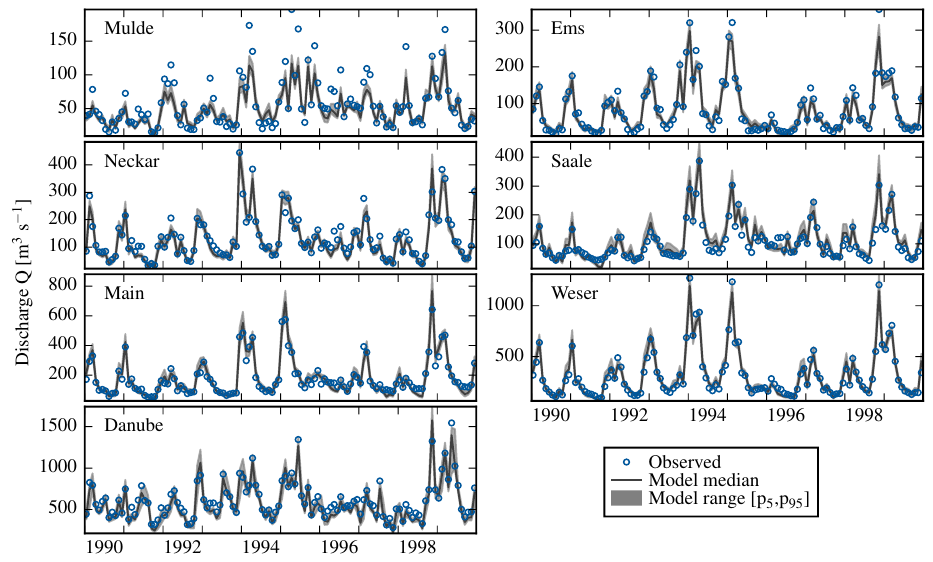
Figure 3. Observed and modeled monthly streamflow for the seven basins, which were used for parameter inference. The figure shows 1 decade (1990–1999) of the evaluation period. The solid dark gray line depicts the median model results and the light gray band depicts the range between the 5th and 95th percentile of the 100 ensemble